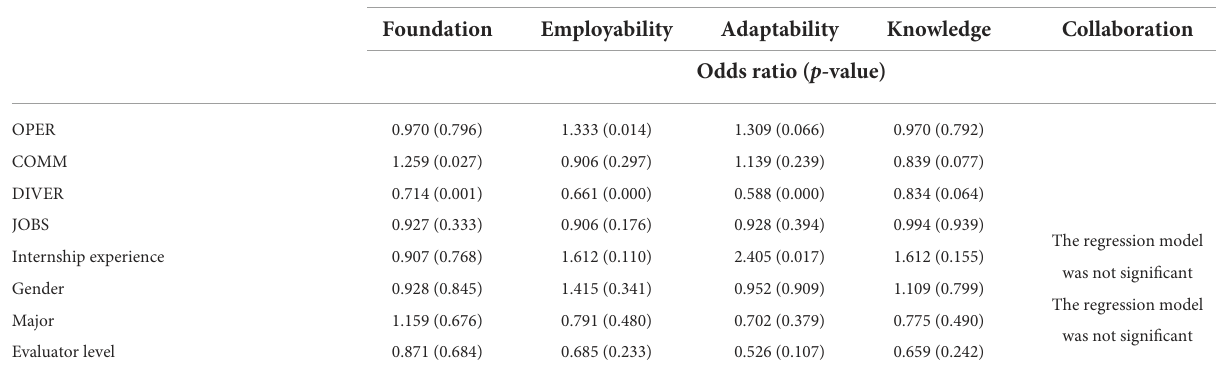
TABLE 4 The hypothesis results of the